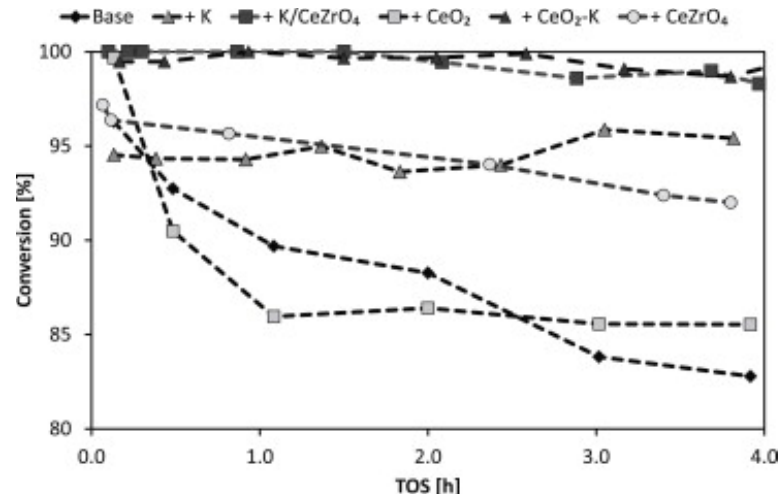
Figure 11. Ethanol conversion as a function of time on stream (TOS) for Ni/MgAl 2 O 4 (base) with different promoters. Reprinted with permission from Ref. [90]. Copyright 2022 Elsevier.